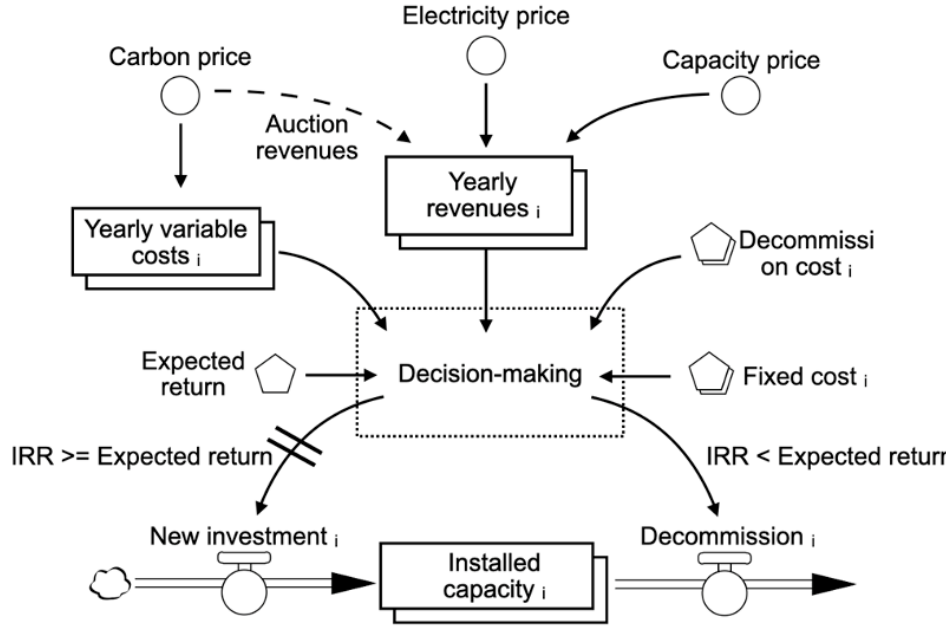
Figure 6. Stock-flow diagram of the balance of the investments of new power plants.